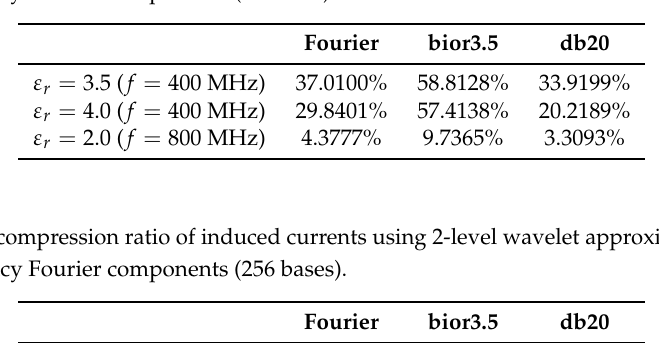
Table 1. Energy compression ratio of induced currents using 3-level wavelet approximate components and low-frequency Fourier components (64 bases).